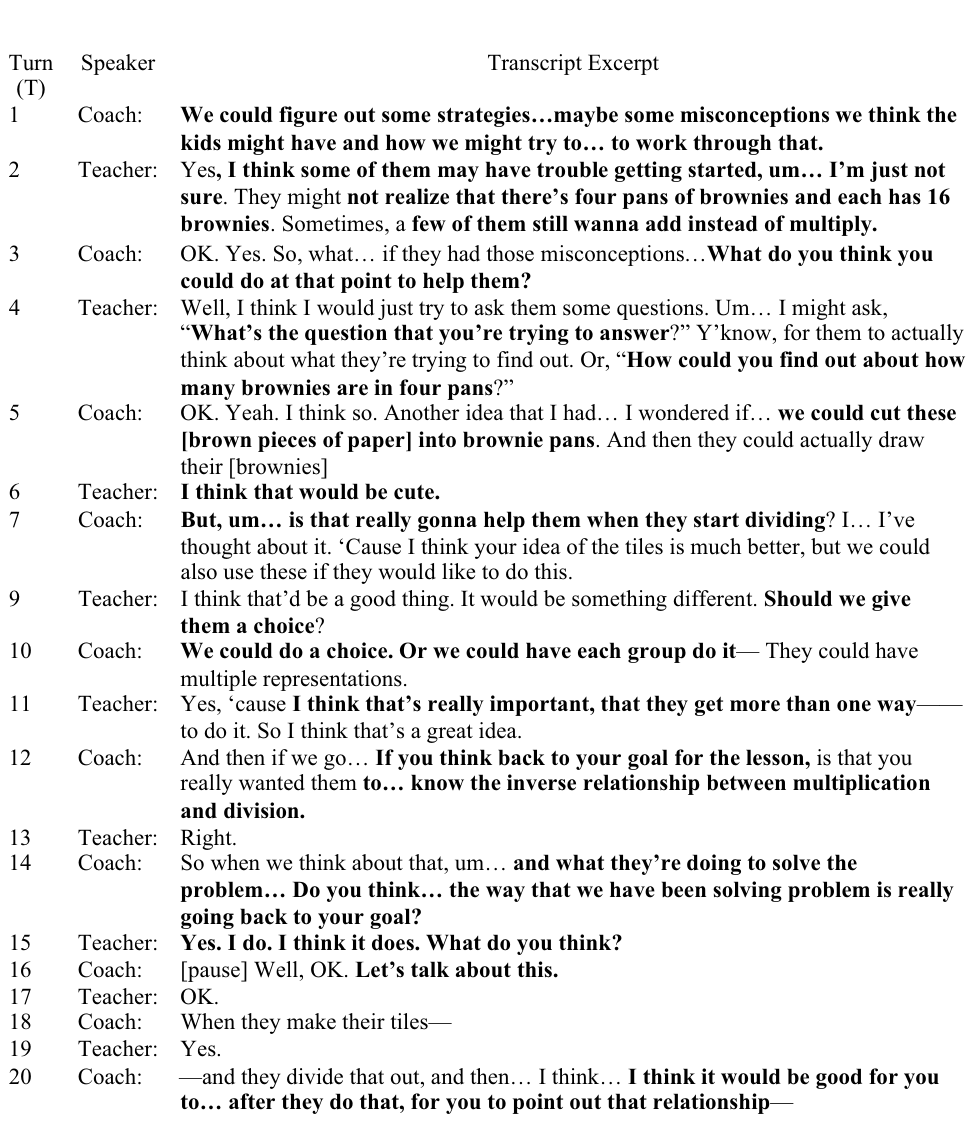
Fig. 7 Excerpt illustrating low-growth theme